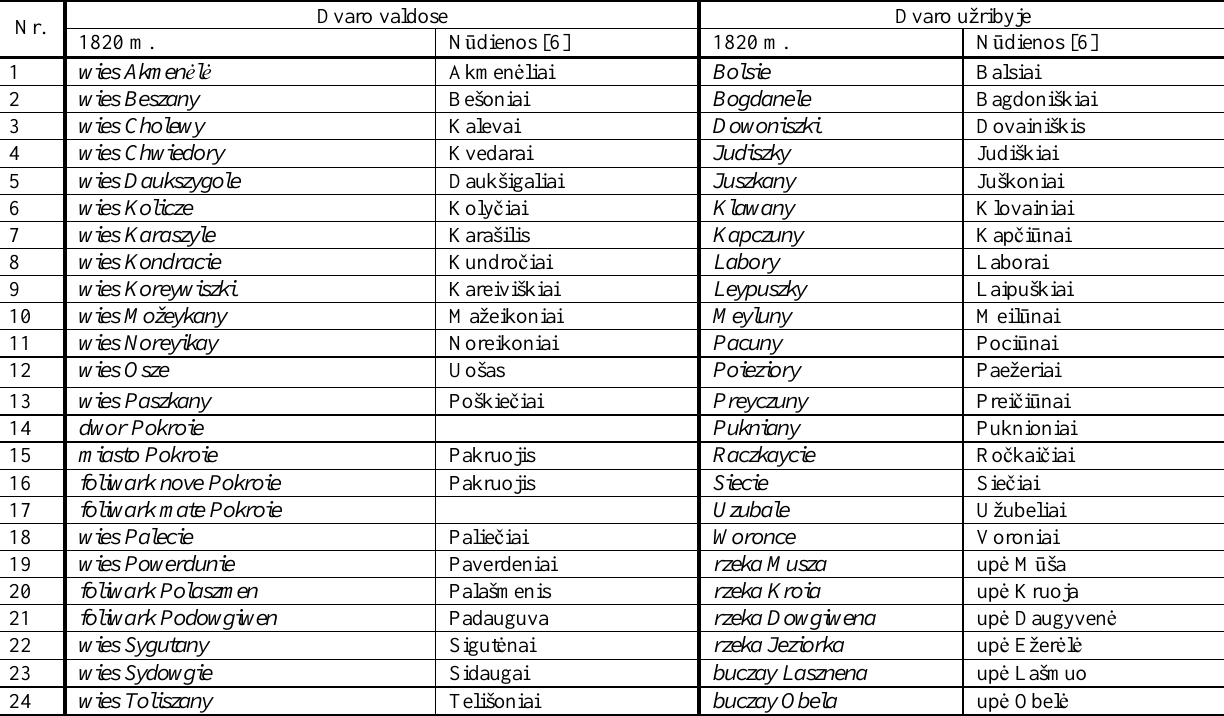
Table 2 . Names of the toponyms and hydronims plan of land estates of Pakruojis Dvaro valdose Dvaro užribyje Nr. 1820